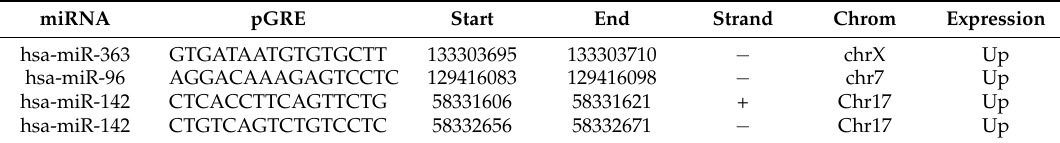
Table 2. Glucocorticoid responsive element (GRE) sites predicted on miRNA promoter regions. miRNA pGRE